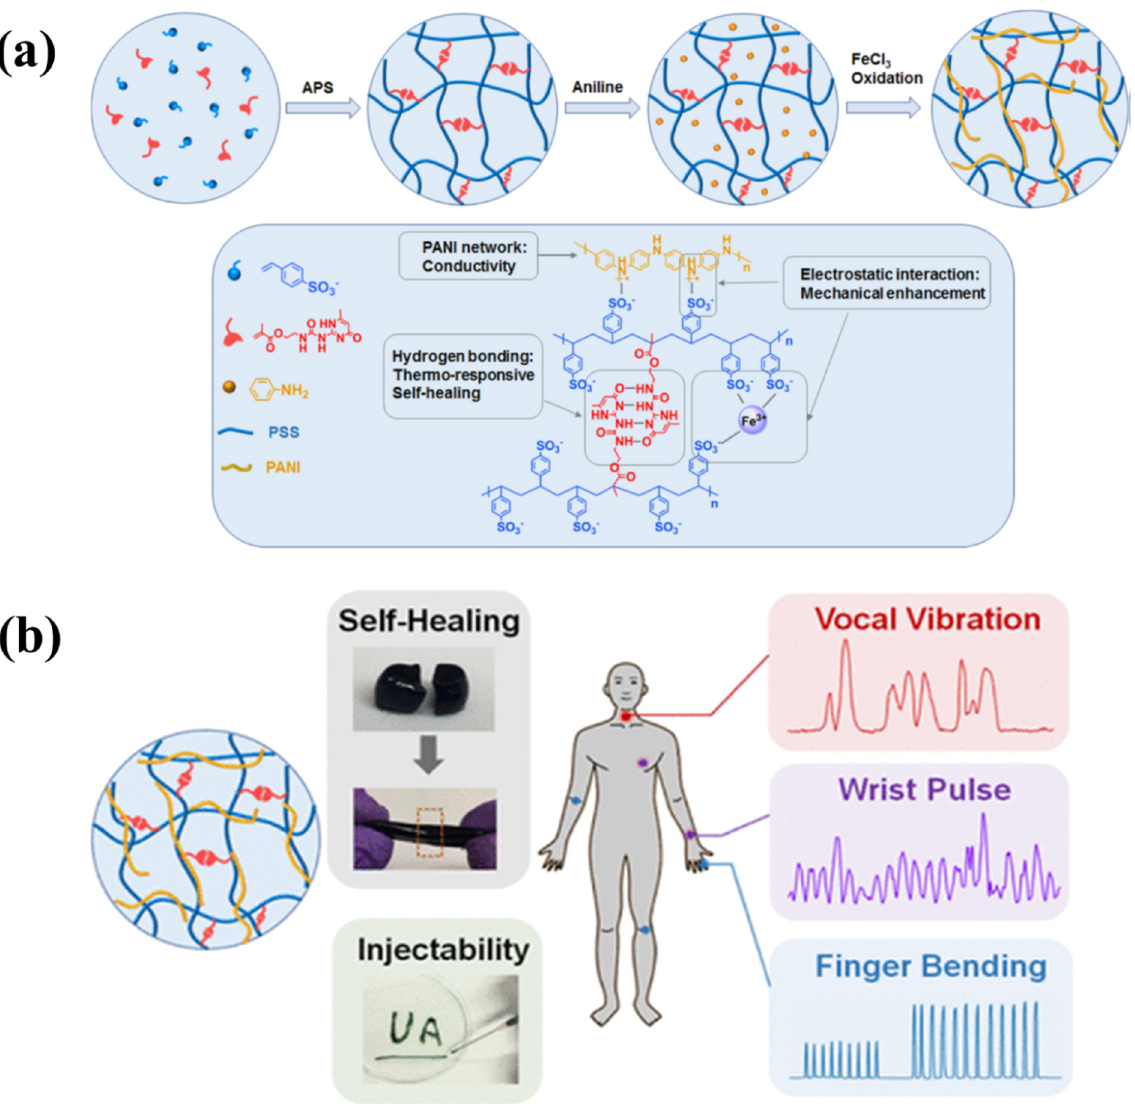
Figure 6. ( a ) Schematic illustration of synthesis process of the supramolecular conductive PANI/PSS − UPy hydrogels and the formation mechanism, ( b ) application in various human motions. Reprinted from Reference [68] with permission from the American Chemical Society.